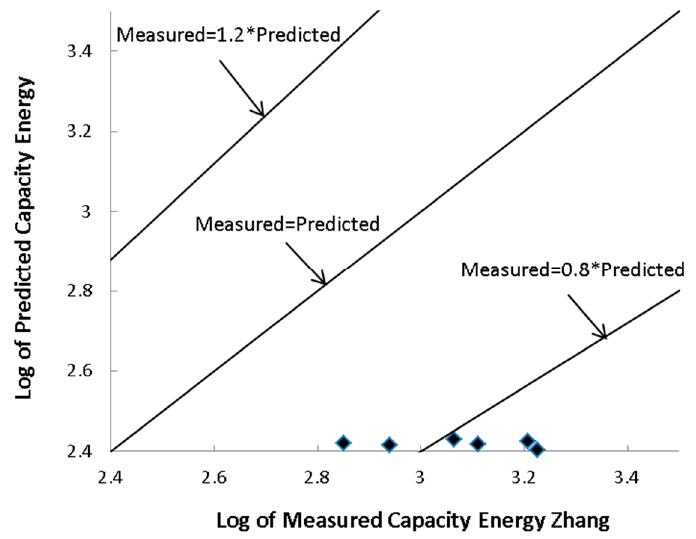
Figure 11. Capacity energy predicted by Zhang’s equation versus the measured values of laboratory tests.